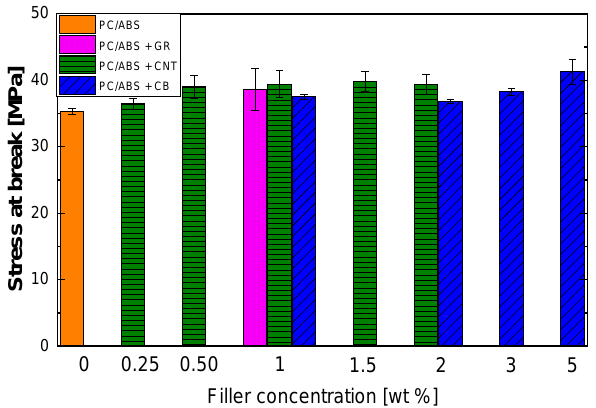
Figure 8. Stress at break of composites obtained by melt blending at different fillers concentrations.